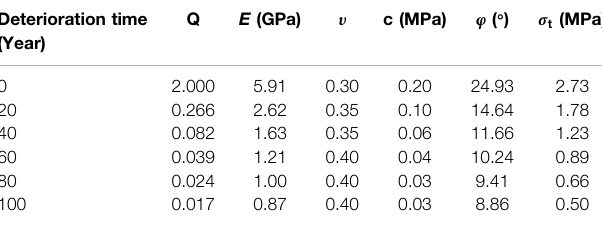
TABLE 6 | Time-dependent mechanical parameters of rock mass during